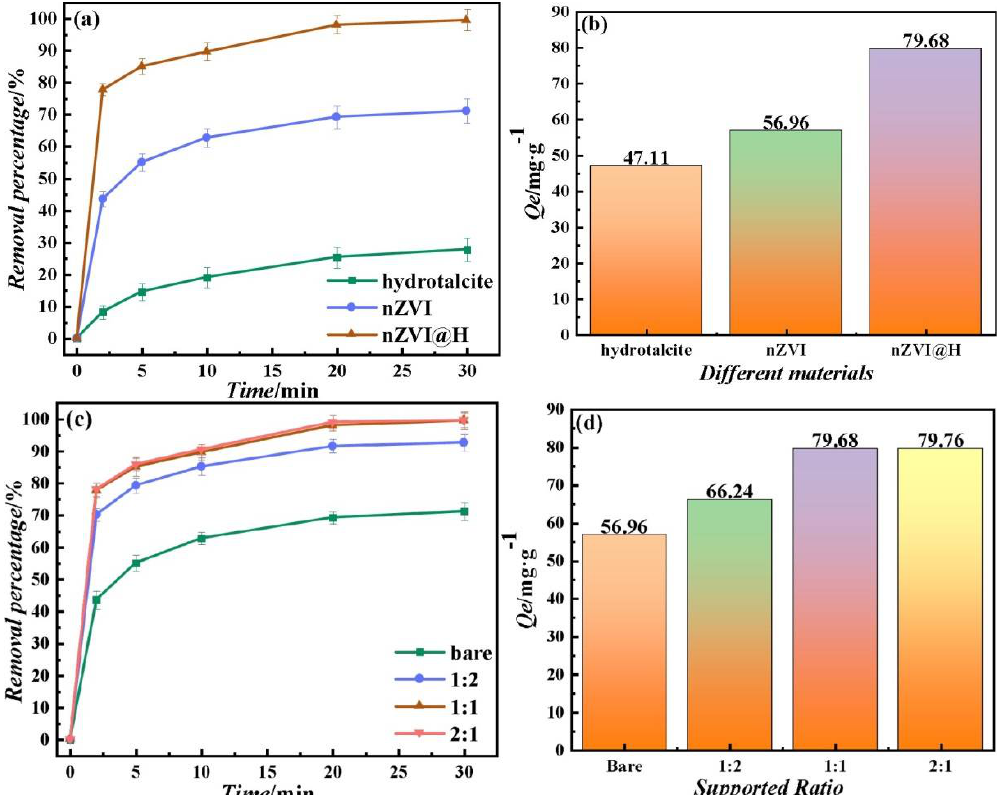
Figure 6. ( a ) Comparative degradation of MB using different materials. The dosage of hydrotalcite, nZVI and nZVI@H (hydrotalcite:Fe = 1:1) are 0.5g·L −1 with a pH of 9, an initial MB concentration of 40 mg·L −1 , and a temperature of 20 °C; ( b ) equilibrium adsorption of different materials; ( c ) com- parative degradation of MB using nZVI@H with various ratios (hydrotalcite/iron mass). The dos- ages of nZVI and nZVI@H are 0.5g·L −1 with pH of 9, an initial MB concentration of 40 mg·L −1 , and a temperature of 20 °C; ( d ) equilibrium adsorption of different supported